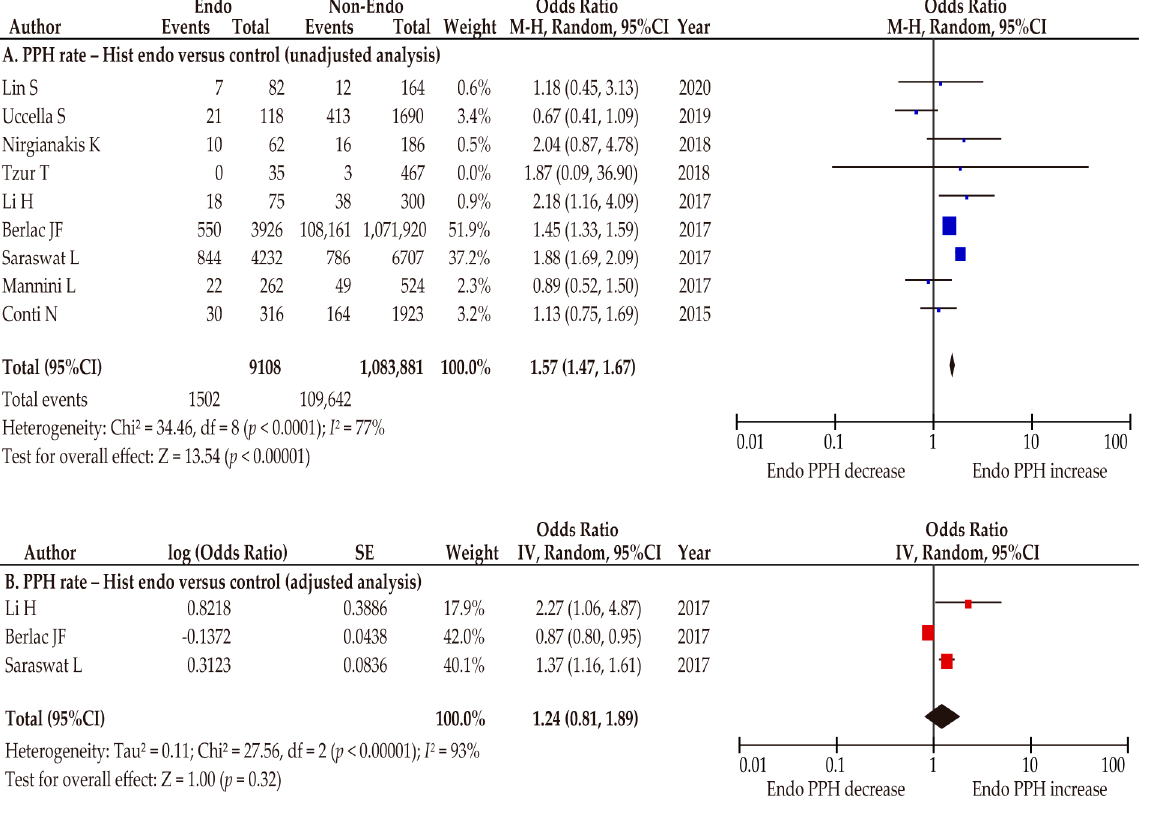
Figure 7. Meta-analysis of the effect of histologically diagnosed endometriosis on the rate of postpartum hemorrhage. The pooled unadjusted ( A ) and adjusted ( B ) odds ratios for postpartum hemorrhage between women with histologically diagnosed endometriosis and women without endometriosis are shown. The forest plots were modified within the stratum according to year of publication and relative weight (%) of the study. Heterogeneity was considerable in both analyses (( A ), I 2 = 77%; ( B ), I 2 = 93%). Some values listed might differ slightly from the original values because the calculation was performed using Revman v5.4.1. Abbreviations: CI, confidence interval; Endo, endometriosis; Hist endo, histologically diagnosed endometriosis; PPH, postpartum hemorrhage.